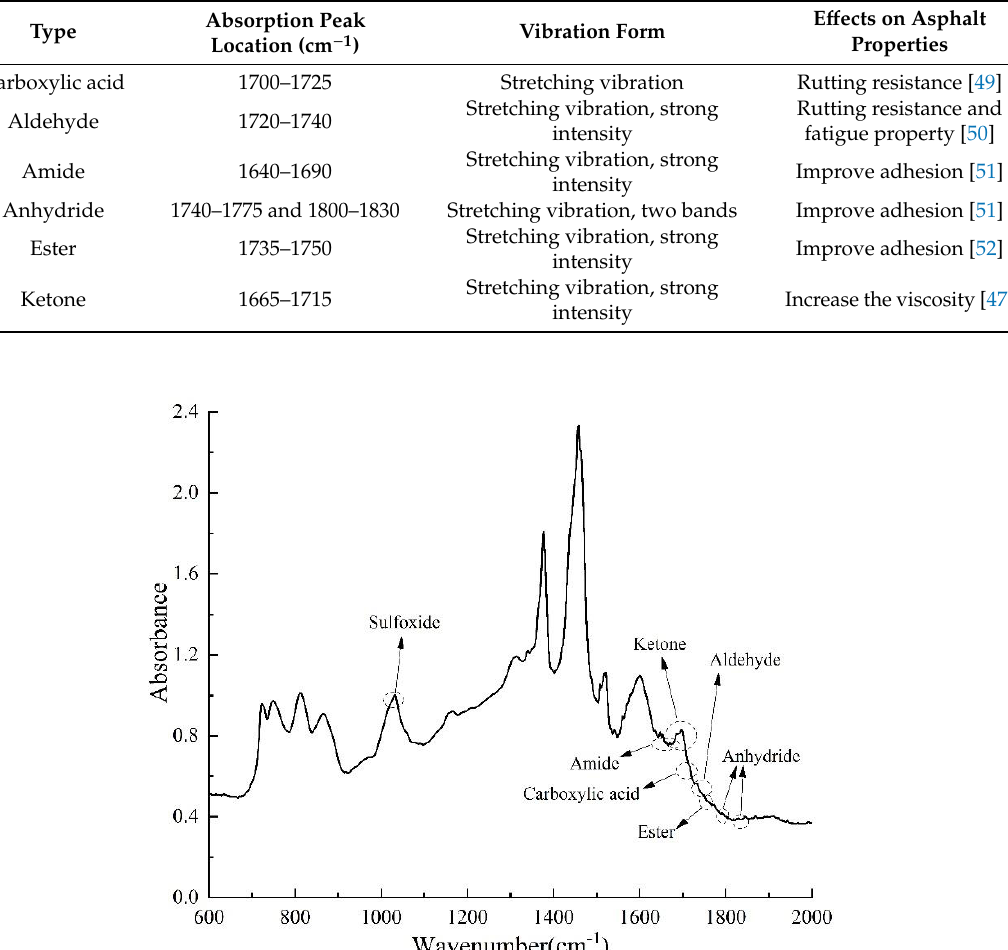
Table 4. The wavenumber range and vibration form of each C = O group and its influence on asphalt.